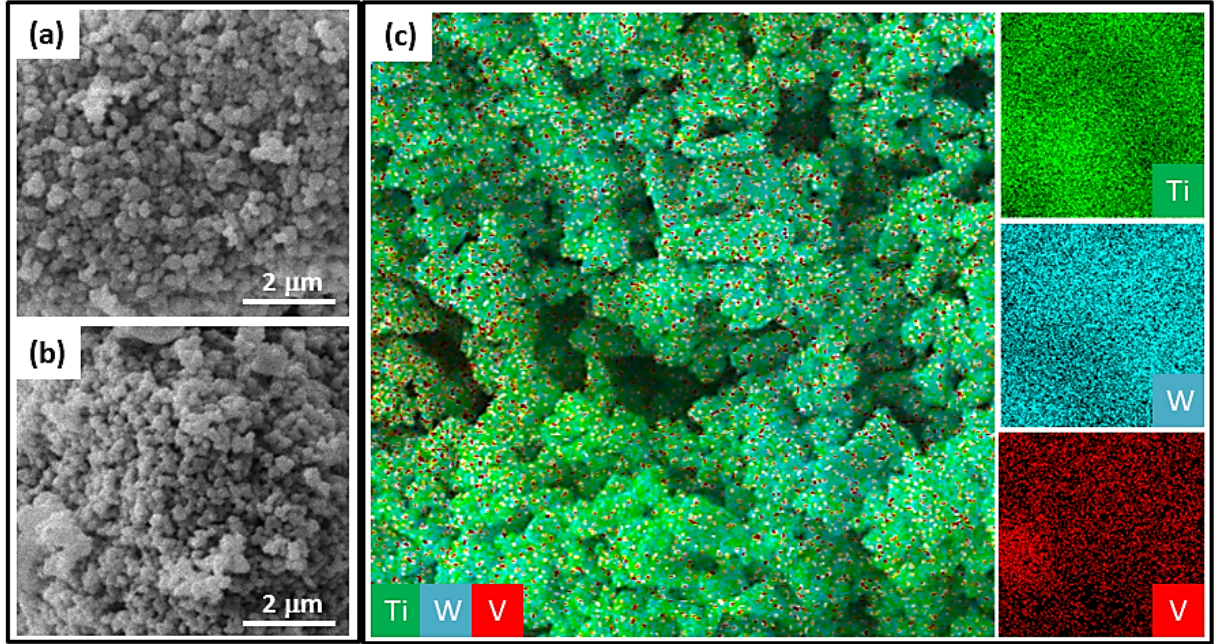
Figure 5. SEM micrographs of ( a ) TWV3 and ( b ) sintered TWV5 MON ; ( c ) representative EDS Figure 3. SEM micrographs of ( a ) TWV3 and ( b ) sintered TWV5 MON; ( c ) representative EDS mapping of V 5+ − doped samples, with indication of Ti , W, and V elements. mapping of V 5+ -doped samples, with indication of Ti, W, and V